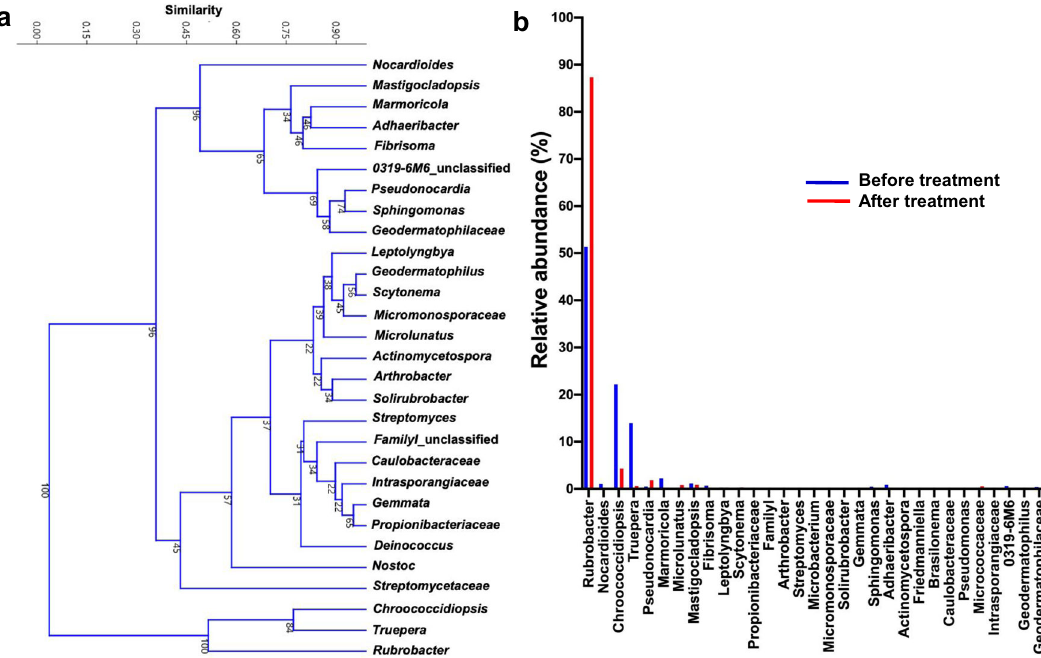
Fig. 4 Analysis of the bacterial community in Copan stone at Structure 10L-18. a Phylogenetic tree of identi fi ed bacteria. b Variation of relative abundance of bacterial species after bacterial